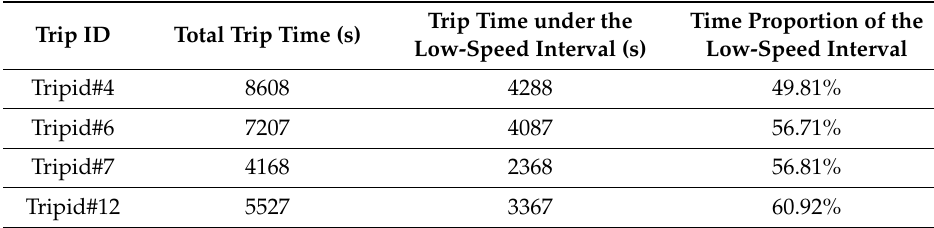
Table 9. The comparison of time